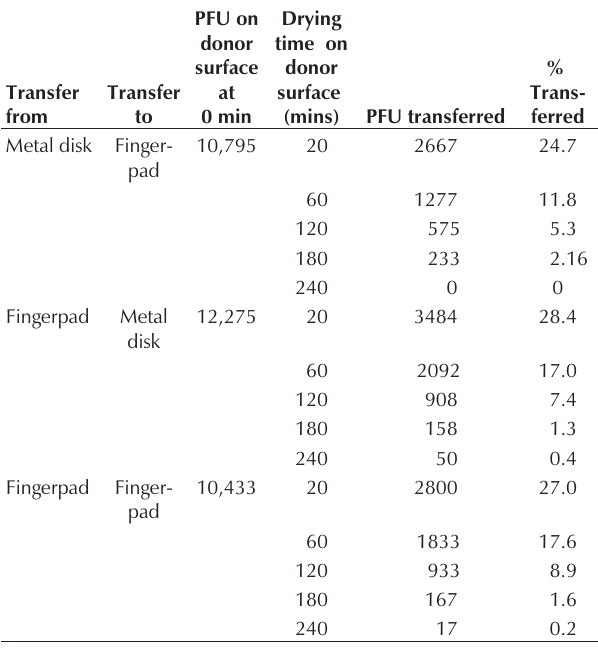
Transfer of infectious hepatitis A virus between contaminated and clean